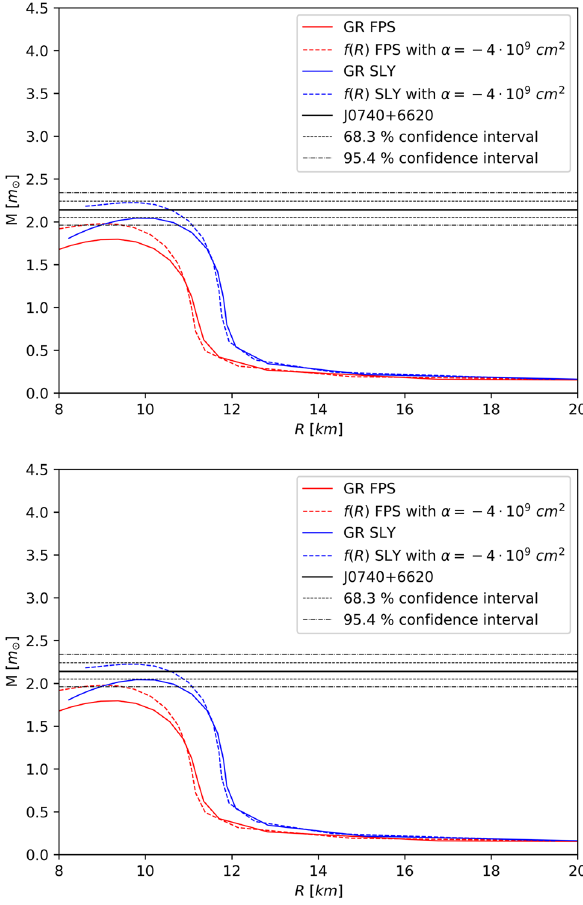
Fig. 7 Differencebetweenthemass(upperpanel)andtheradius(lower panel) obtained, given a central density value ξ , with f ( R , Q ) = R + α R 2 and GR, for the HS(TDA) EoS